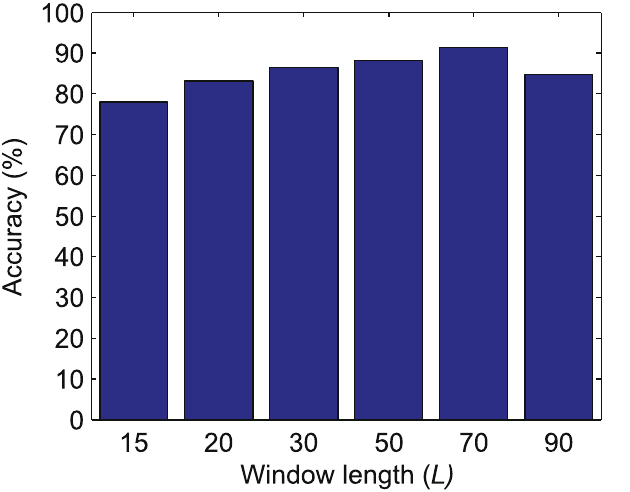
Figure 3. Effects of varying the sliding window length L on eMCI classification accuracy, derived by the hybrid dynamic networks (DN L + DN H + DN A